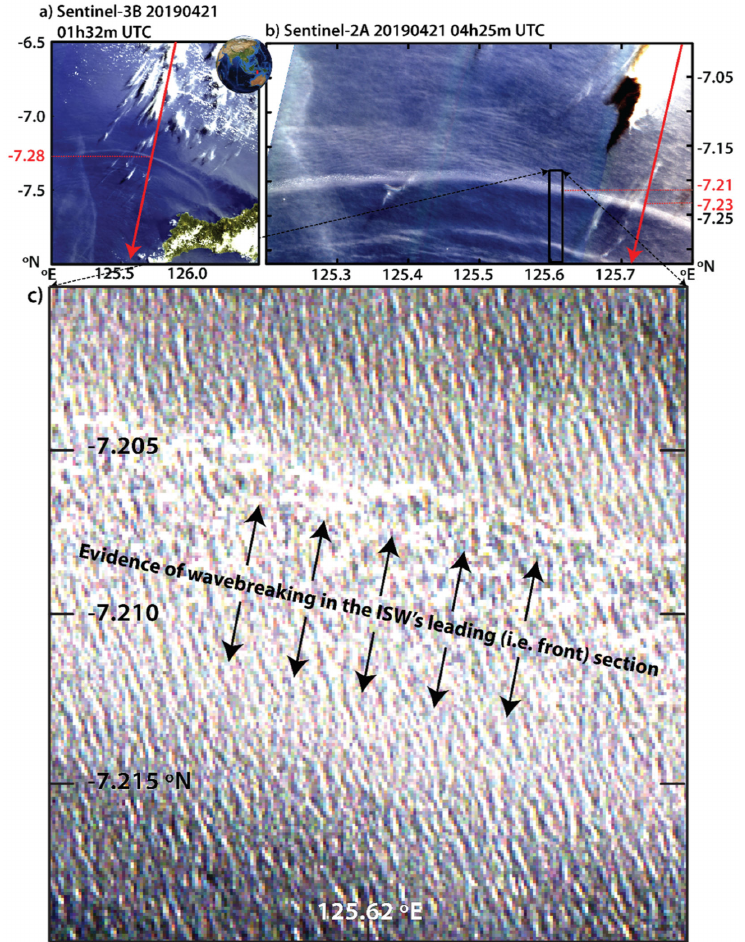
Figure 9. ( a ) Quasi-true color image (Level-1b) acquired on 21 April 2019 at 01 h 31 m UTC by the OLCI sensor onboard the Sentinel-3B satellite. The red line represents the ground-track of the satellite, which in this case is practically parallel to the ISWs’ direction of propagation. ( b ) Image taken in the visible band by the Multispectral Instrument (MSI) onboard the Sentinel-2A satellite on 21 April 2019 at 04:25 UTC showing sea surface signatures of the same ISW packet seen in ( a ) approximately 3 h later. The red line also represents the ground-track of the satellite Sentinel-3 in the same day but at a different time. ( c ) Zoomed section of the leading ISW seen in ( b ). Note the bright spots aligned in bands, which are evidence of whitecaps generated by breaking surface